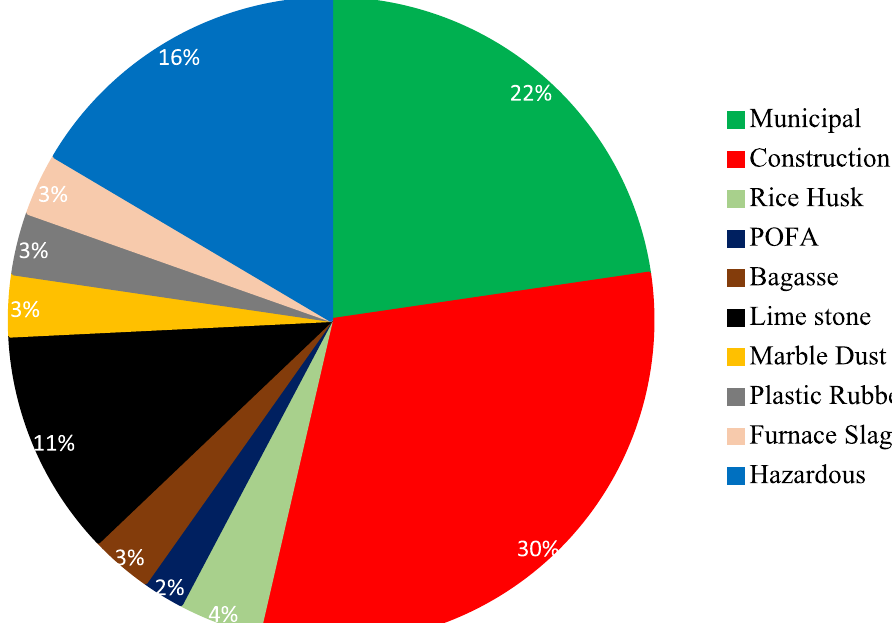
Fig. 1 Different waste production (Ofuyatan et al.,